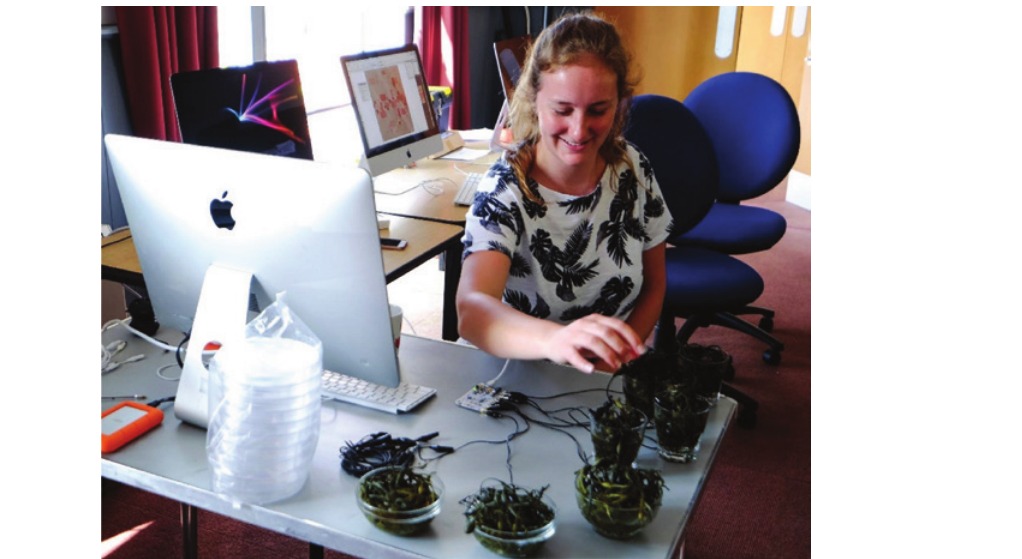
figure 11: sounds of the West coast – seaweed in water connected to a touch board and computer (source: